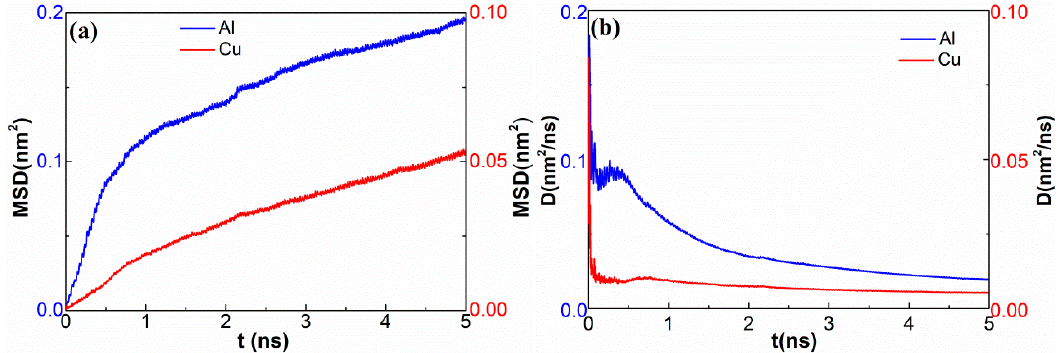
Figure 8. ( a ) MSD results of Al and Cu along the z-direction. ( b ) Results of running diffusion coefficients-half of slope of the MSD curves.